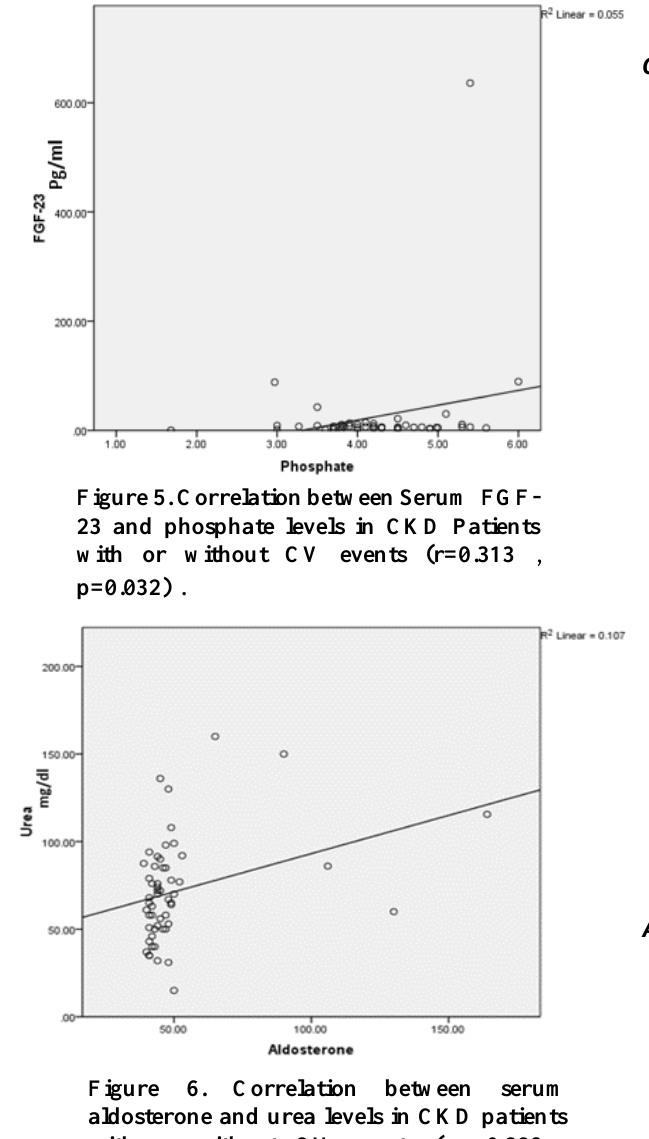
Figure 6. Correlation between serum aldosterone and urea levels in CKD patients with or without CV events ( r=0.328 , p=0.015)